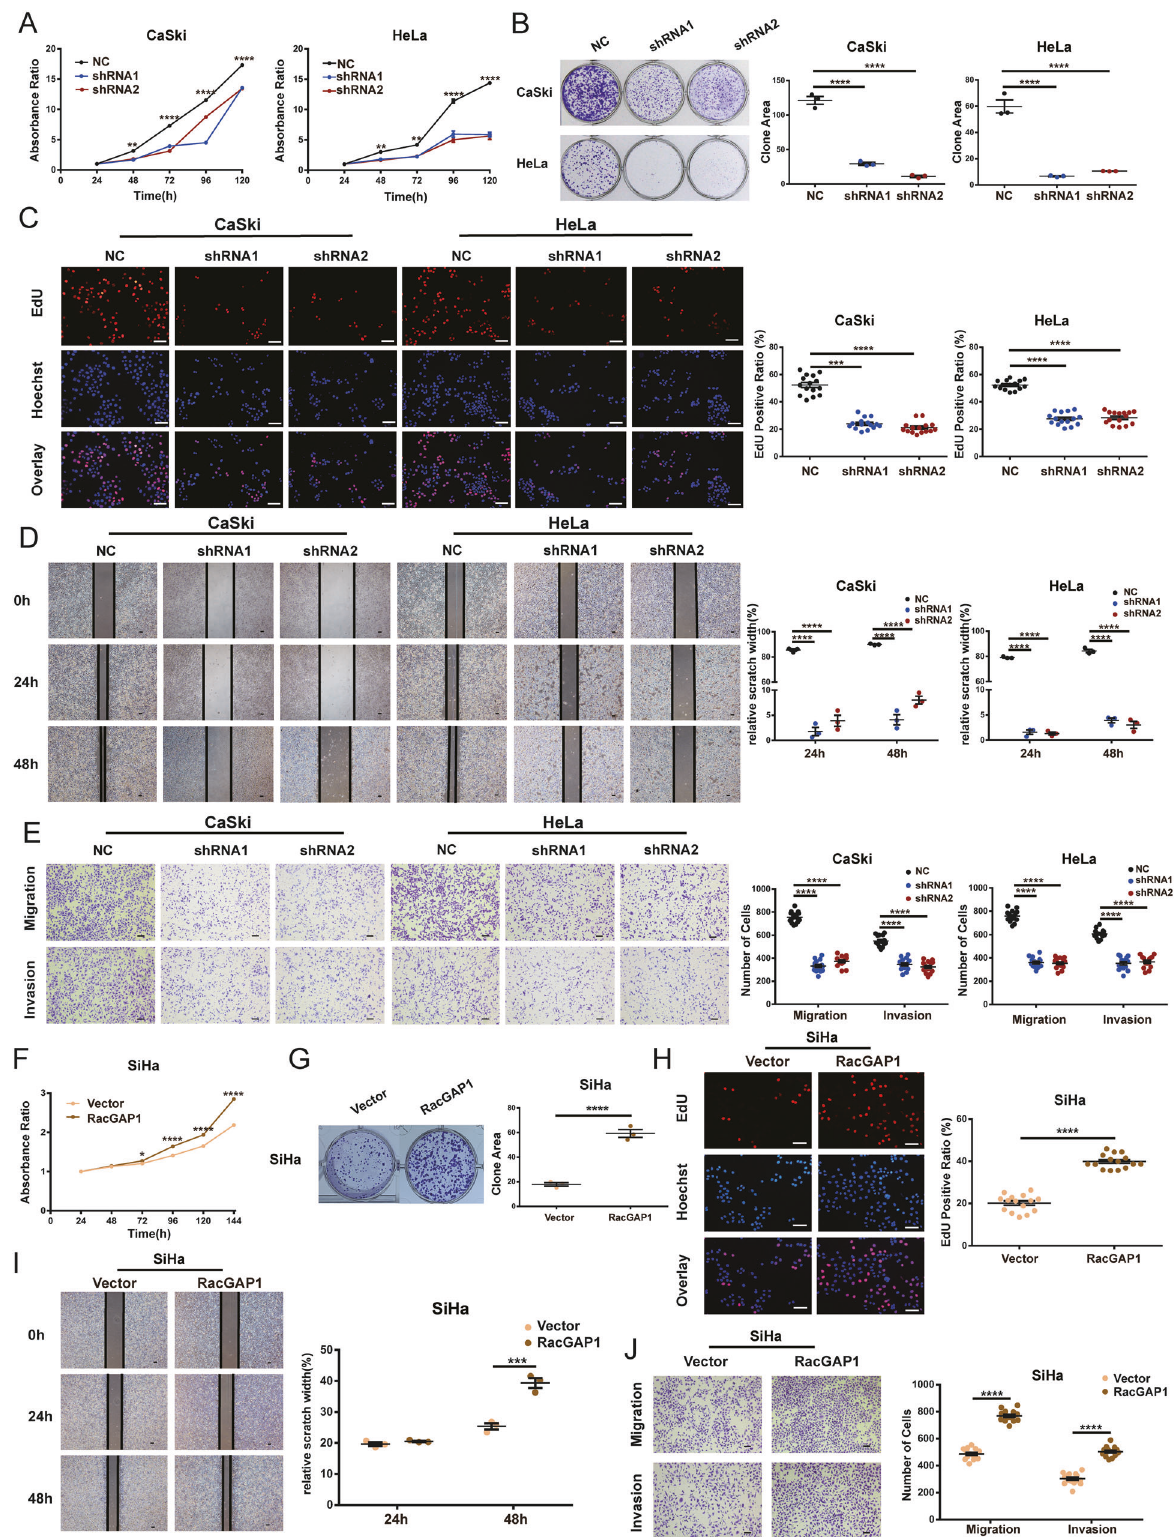
Fig. 3 Effects of RacGAP1 on cell proliferation, invasion, and migration. A – C Cell proliferation was detected by CCK8 assays, clone formation assays, and EdU assays after RacGAP1 knockdown in CaSki and HeLa cell lines. D , E Wound healing assay and transwell assays showed downregulation of RacGAP1 reduces the ability of invasion and migration in CaSki and HeLa cells. Scale bar = 50 μ m. F – H Cell proliferation was detected by CCK8 assays, clone formation assays, and EdU assays after RacGAP1 upregulated in SiHa cell line. I , J Wound healing assay and transwell assays showed upregulation of RacGAP1 promoted the ability of invasion and migration in SiHa cells. Scale bar = 50 μ m. The data were presented as means±SEMs, * p <0.05, ** p <0.01, *** p <0.005, **** p <0.001; RacGAP1 Rac GTPase-activating Protein 1, EdU 5-ethynyl-2 ’ -deoxyuridine, SEM standard error of the mean.